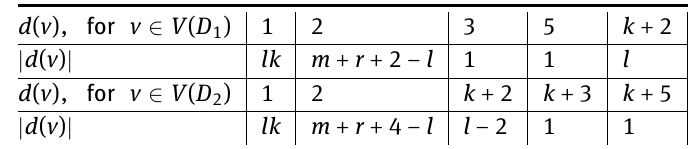
Table 4: Vertex-partitions of the tricyclic graphs D 1 and D 2 .